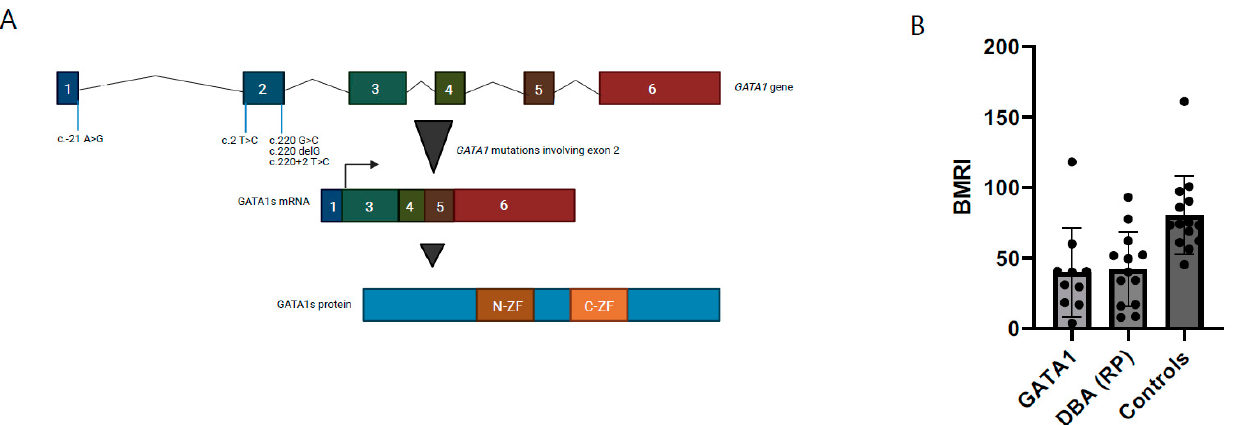
Figure 3. Functional characteristics of GATA-1 DBA. ( A ) Overview of genetic defects at exon 2 in GATA1 , inducing GATA1s exclusively (figure adapted from Ling & Crispino) [40]. ( B ) Bone marrow responsiveness index (BMRI), calculated as [(absolute reticulocyte count) × (patient’s Hb/normal Hb)], depicted for DBA patients with GATA1 defects, ribosomal protein defects from the Dutch DBA Registry and healthy controls.